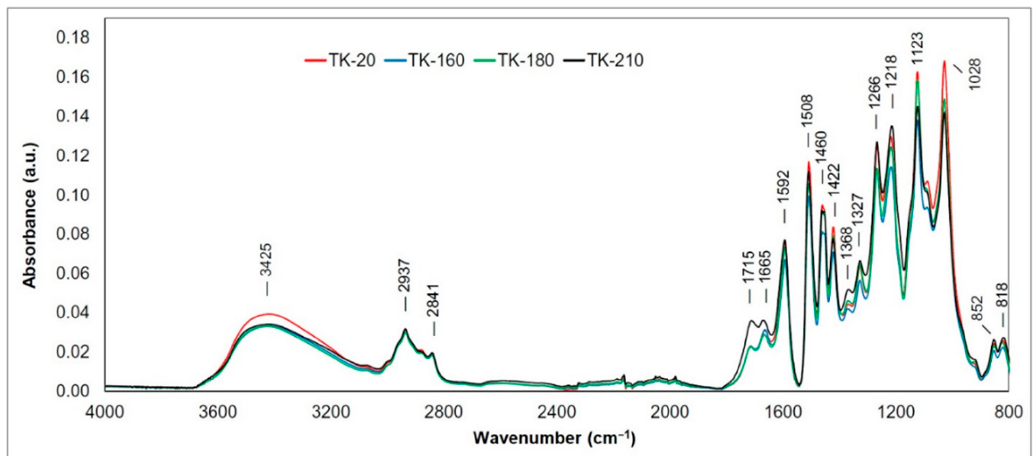
Figure 3. Fourier transform infrared (FTIR) spectra of the untreated and thermally modified teak wood lignin.